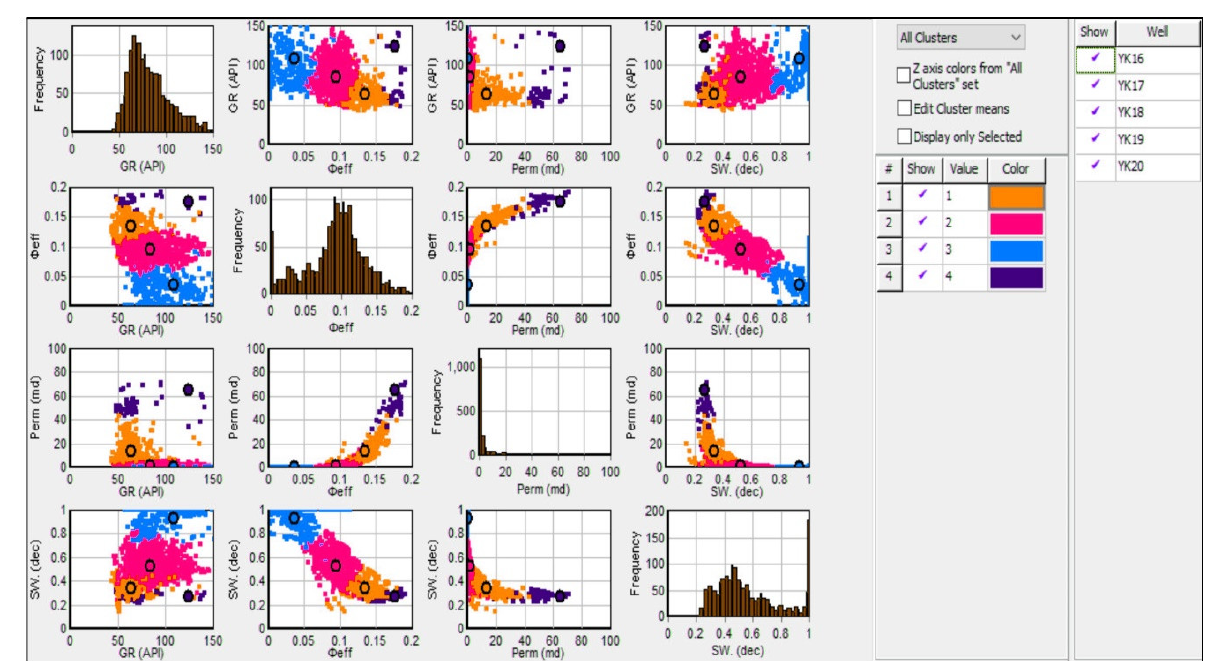
Figure 20. The final graphical results of the clustering assessment.